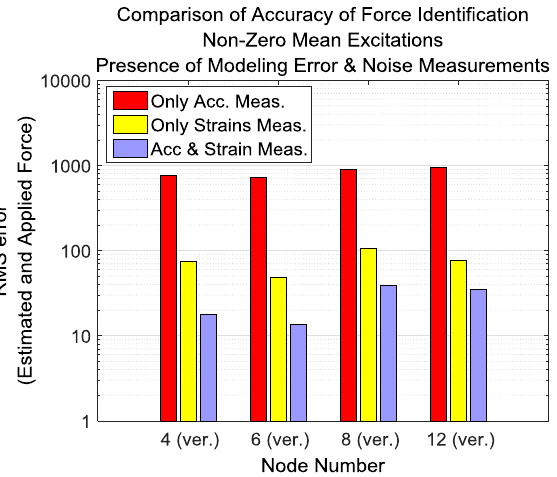
Figure 19. RMS error between the estimated and applied forces for different types of measurements.